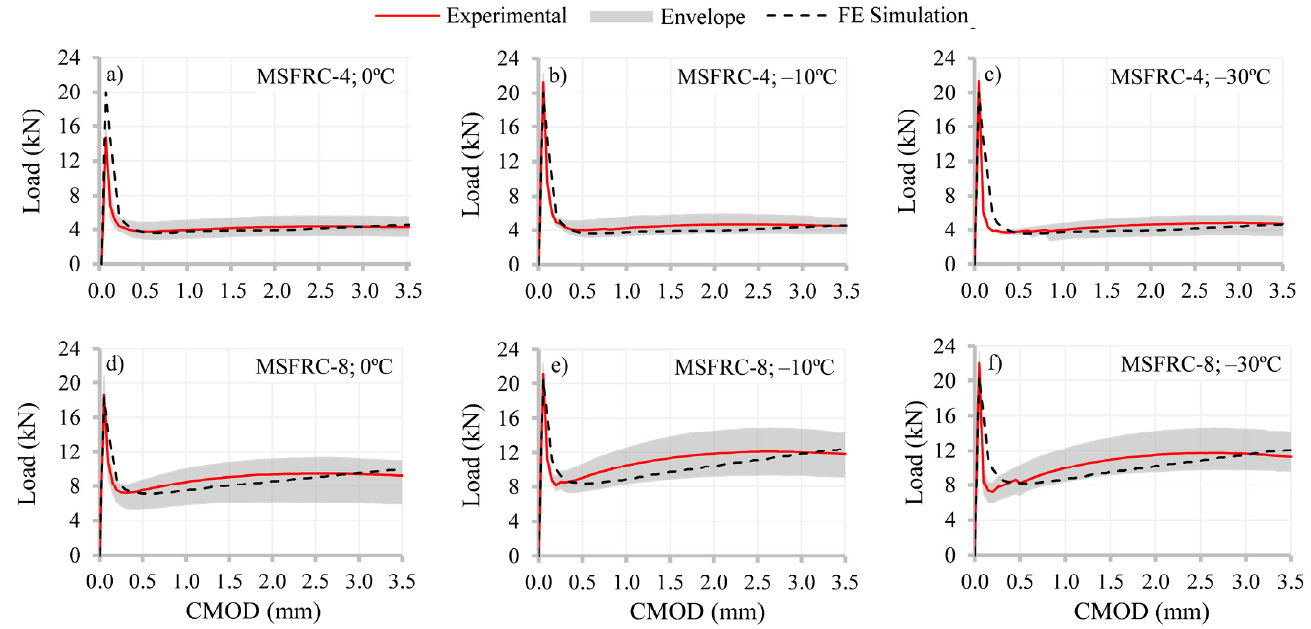
Figure 9. Results in terms of load–CMOD for MSFRC-4 and MSFRC-8 using f R,NL / f R,EXP at reference temperature to derive the constitutive curves.